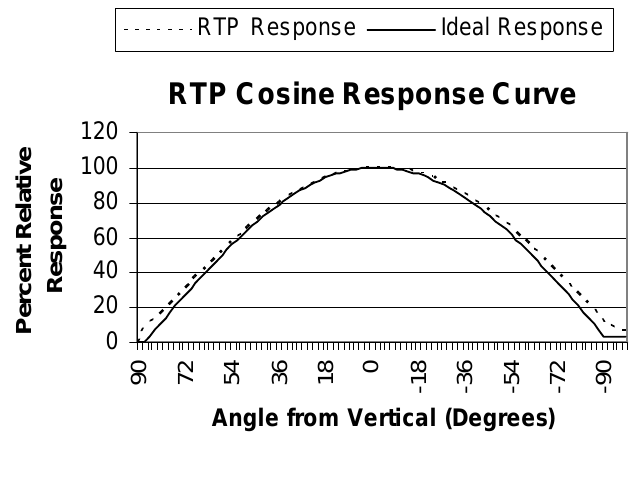
Figure 14. Ideal response and real measured response curves, both according to the angle of inciden